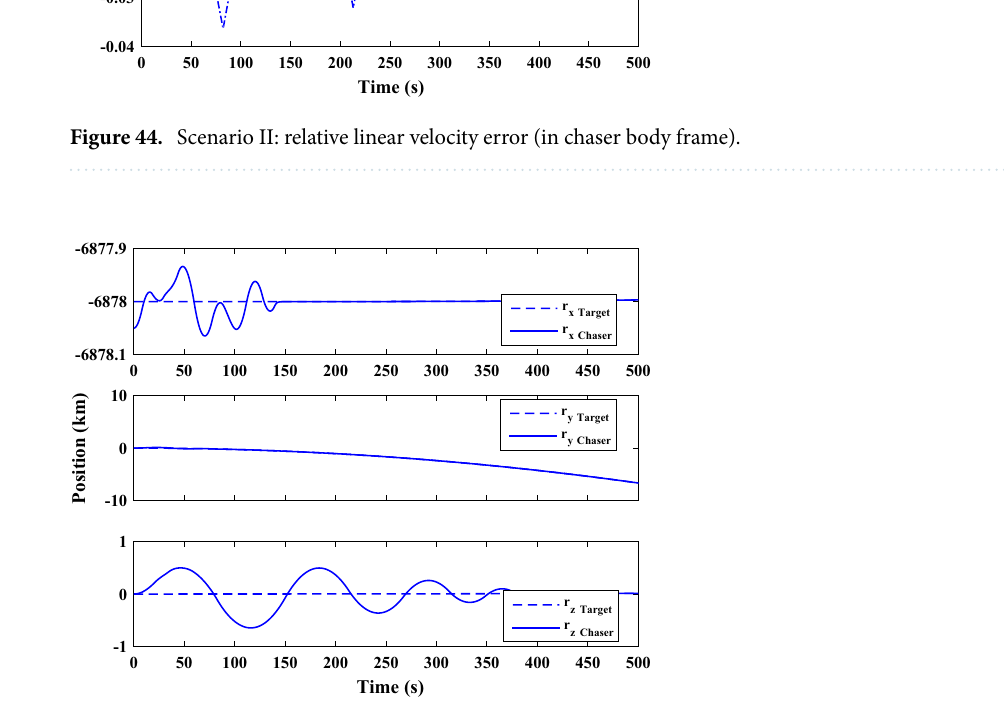
Figure 45. Scenario II: position tracking (in chaser body